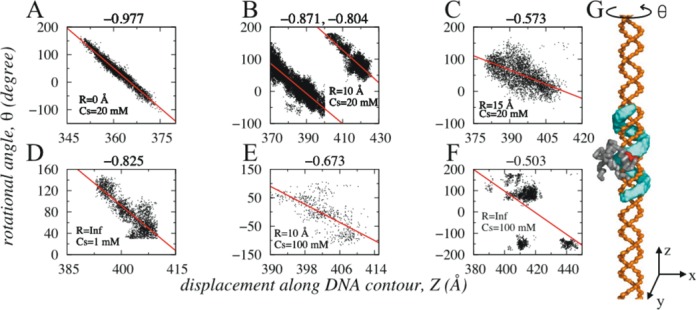
Correlation between transversal (Z-axis) and rotational (θ) motions of Sap-1 at various salt conditions and degree of DNA confinement. For fixed salt condition (20 mM), correlation coefficient (mentioned on the top of each figure) decreases with increase in R (A–C). (B) indicates fragmented sliding events (discussed further in Figure 5) at two distinctly different major grooves separated by ∼34 Å. The correlation however, can be high (D) even on dynamic DNA without confinement if the salt condition is extremely low (1 mM). At higher salt condition (100 mM) reasonable correlation is found for strong confinement (R = 10 Å in E), which reduces significantly if the confinement effect is not imposed (F). The red lines in each figure represent the best fits. Figure 4G presents the sample trace (cyan color) of rotation coupled sliding performed by Sap-1 along the major grooves of rigid DNA molecule.